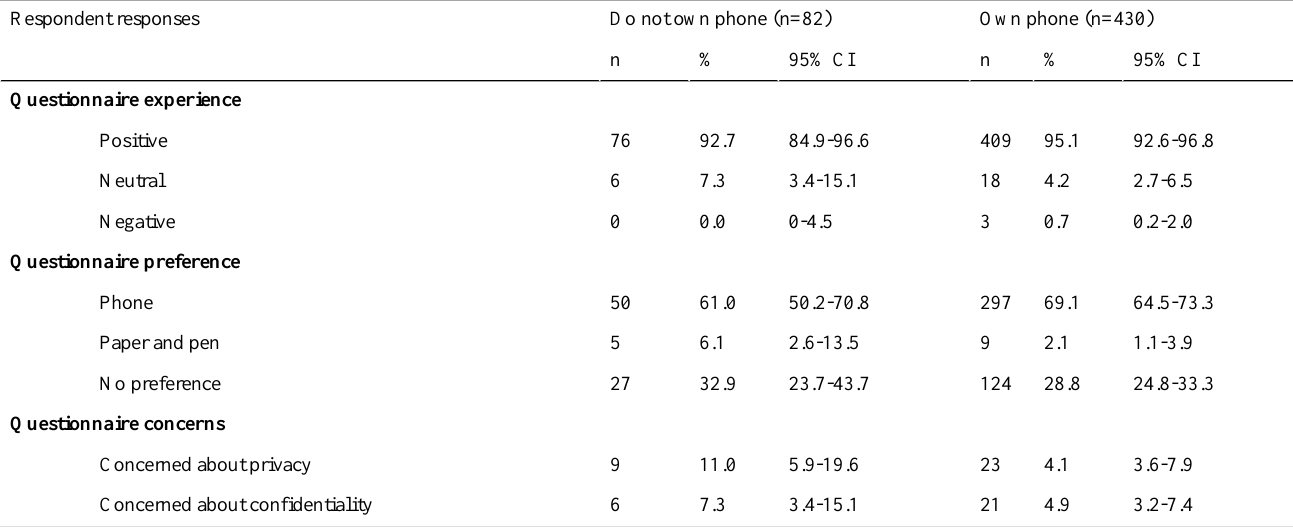
Table 4. Questionnaire experience and preference of sample